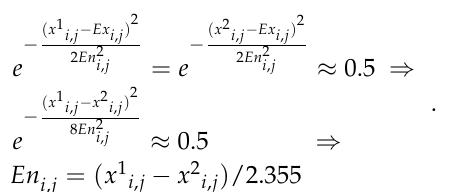
Figure 4. Schematic diagram of cloud generator (CG). ( a ) Forward CG; ( b ) backward CG.